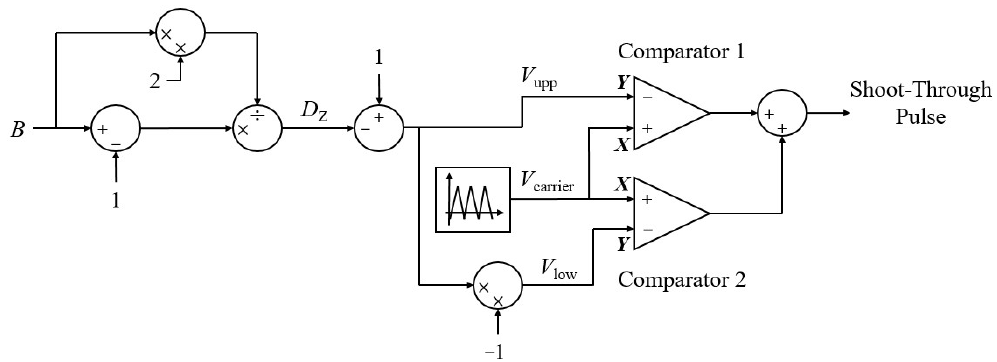
Figure 10. Shoot-through control unit of the PI-based BC.